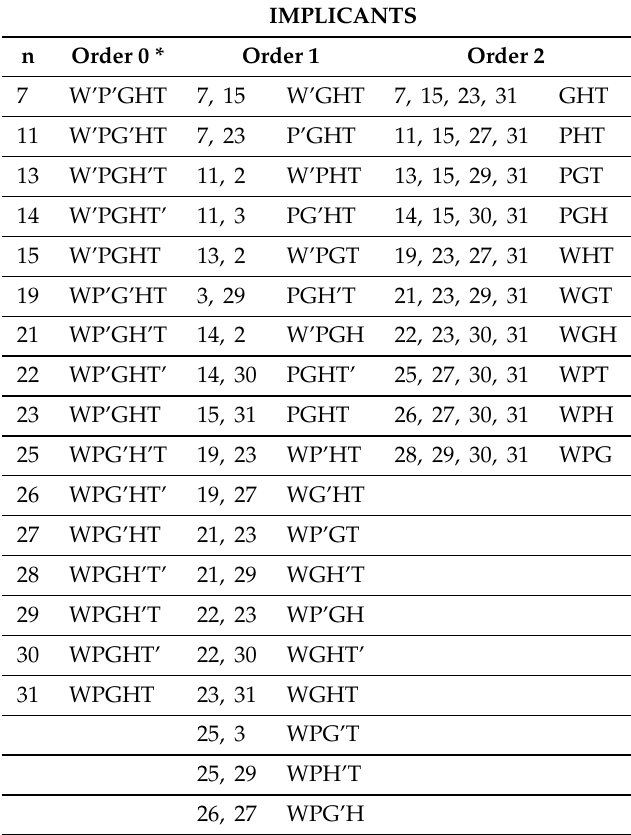
Table A1. Implicants in the minimization of the MetS